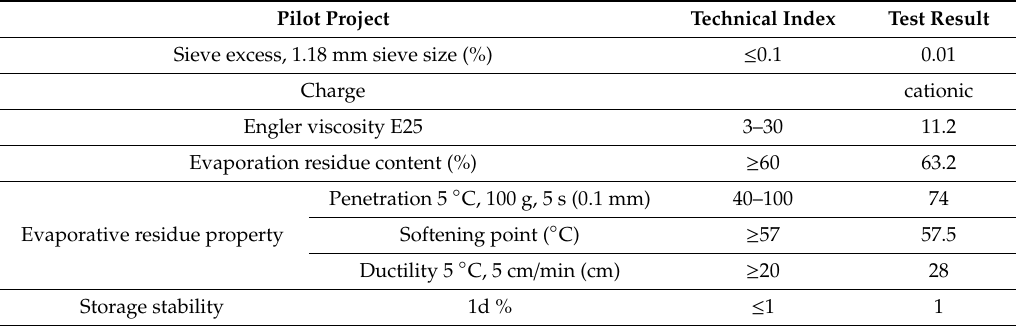
Table 3. Technical indexes of modified emulsified asphalt.